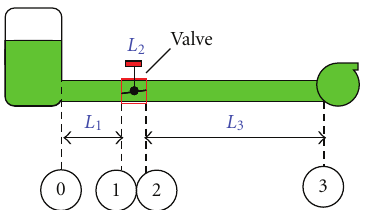
Figure 10: Modified analytical model with valve.